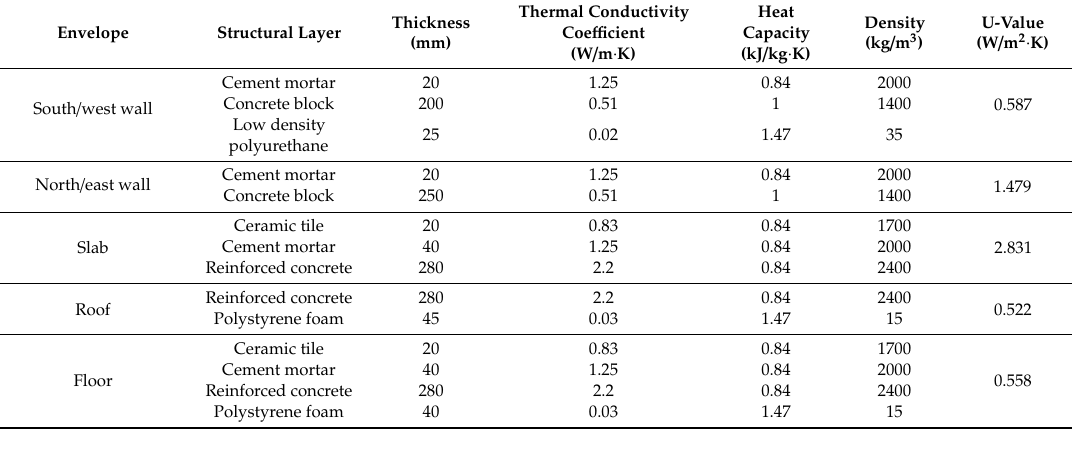
Table 1. Thermal parameters of building envelopes.